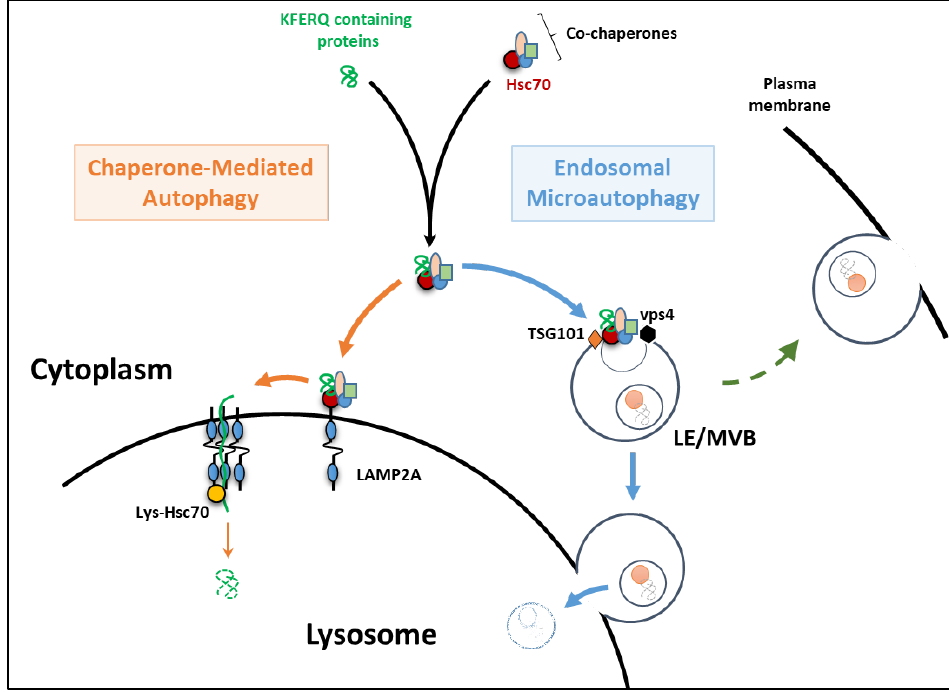
Figure 1. Chaperone-mediated autophagy (CMA) and endosomal microautophagy (eMI) as described in mammals. The first step (dark arrows) of recognition of the KFERQ motif-containing proteins by HSC70 and its co-chaperones is shared by both pathways. During CMA (orange arrows), the substrate-chaperone complex is then directed to the lysosomal membrane through specific binding to the cytosolic tail of the lysosomal-associated membrane protein 2A (LAMP2A). LAMP2A then organizes into a multimeric complex that allows substrates to translocate across the lysosomal membrane and reach the lumen for degradation by lysosomal hydrolases. During eMI (blue arrows), the substrate-chaperone complex is transported to late endosomes/multivesicular bodies (LE/MVB) by direct binding of HSC70 to phosphatidylserine residues on the LE/MVB membrane. Members of the ESCRT machinery (including VPS4 and TSG101) will then mediate the internalization of the substrate into intraluminal vesicles. eMI substrates may then be degraded within the LE/MVB itself or upon their fusion with a lysosome. Alternatively, eMI could mediate extracellular protein releases due to the ability of LE/MVB to fuse with the plasma membrane (green dashed arrow).